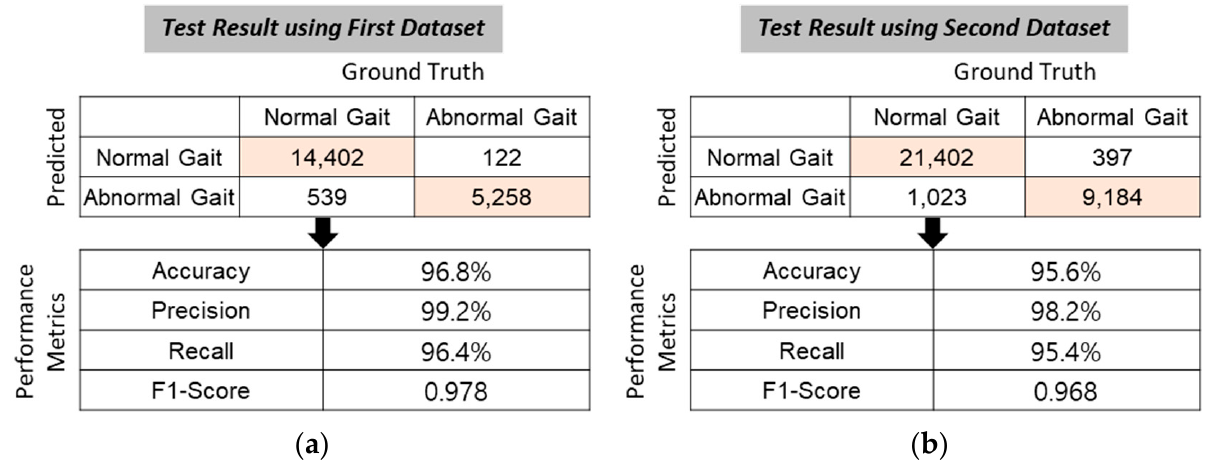
Figure 8. The test results and performance metrics: ( a ) gait classification results and performance metrics of the test results of the first dataset; and ( b ) gait classification results and performance metrics of the test results of the second dataset.